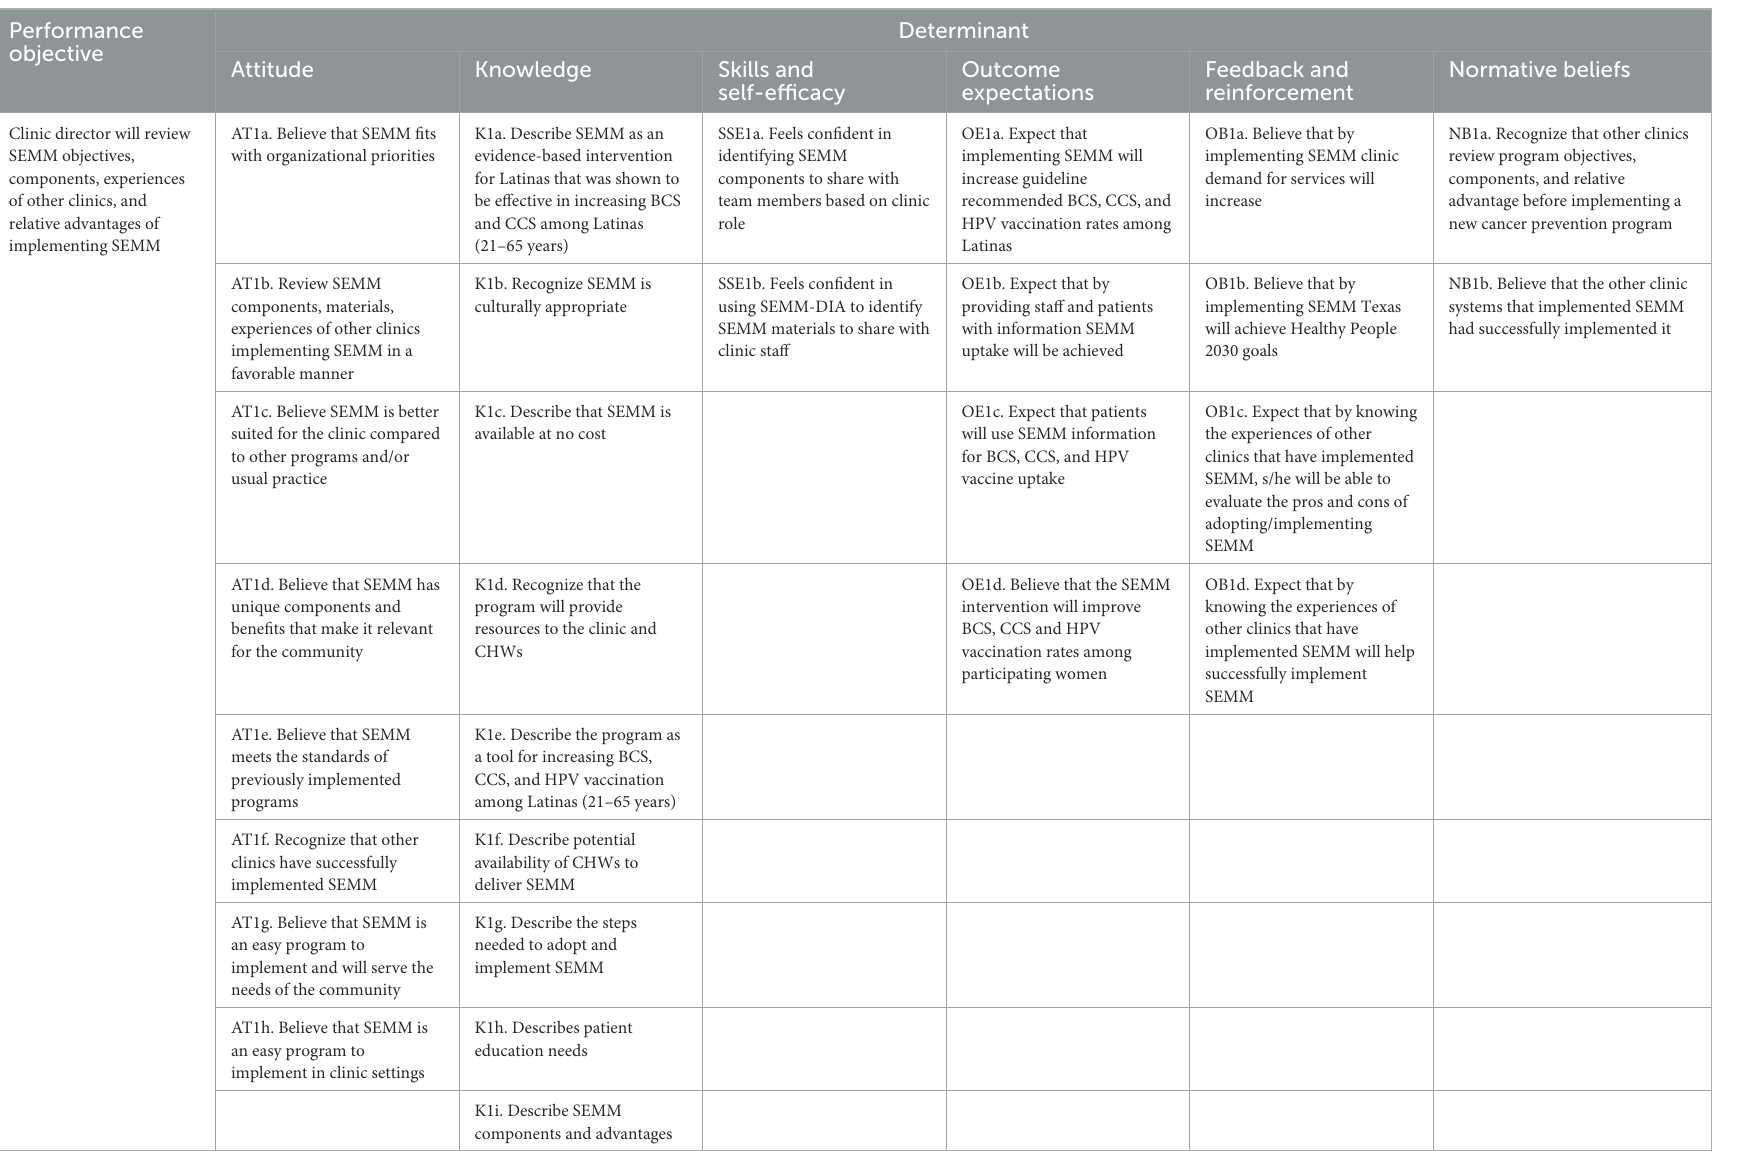
TABLE 4 Matrices of change for implementation (example): clinic